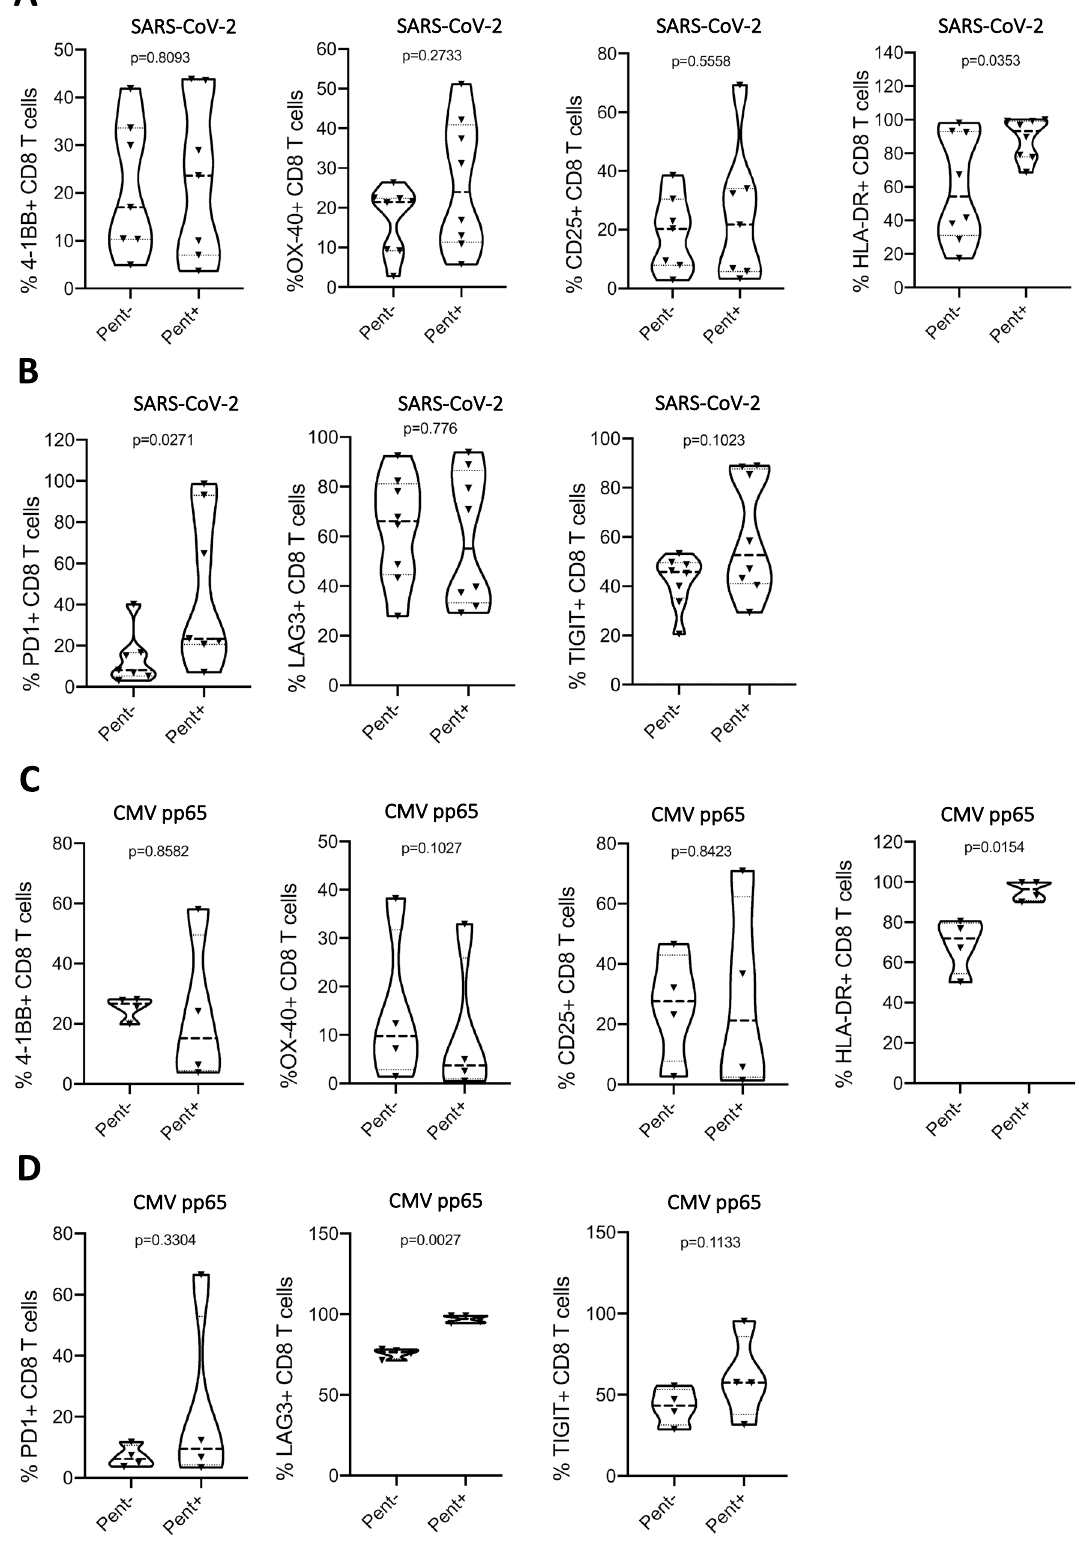
Figure 3. The activation and exhaustion phenotype of rapidly-expanded SARS-CoV-2 and CMV antigen- specific VIL. ( A ) Expression of activation markers, 4-1BB, OX-40, CD25 and HLA-DR, and ( B ) expression of checkpoint genes PD-1, LAG-3 and TIGIT among enriched and expanded SARS-CoV-2-specific CD8 + T cells at day 7 ( n = 8 ). ( C ) Analysis as in a, for CMV-specific CD8 + T cells and ( D ) Analysis as in b, for CMV-specific CD8 + T cells ( n = 4